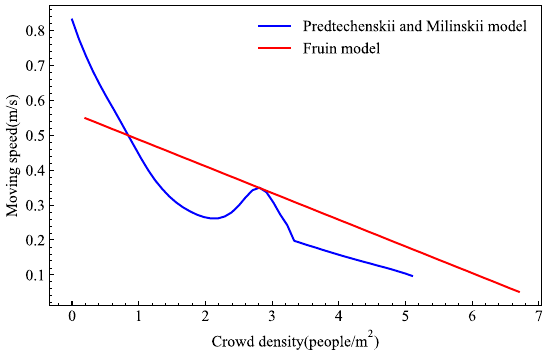
Figure 5. The evacuees’ speed models of moving on straight paths of various scholars.